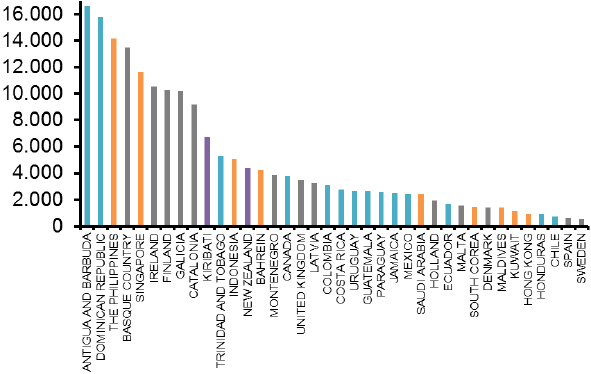
Figure 4. Followers by million inhabitants of NMS’s Twitter ac- counts (from beginning to 30 August